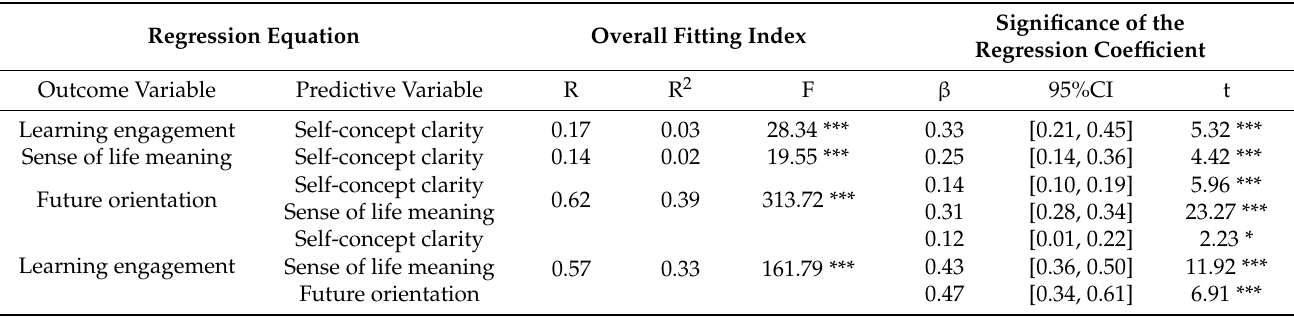
Table 2. The pathways of the multiple mediation